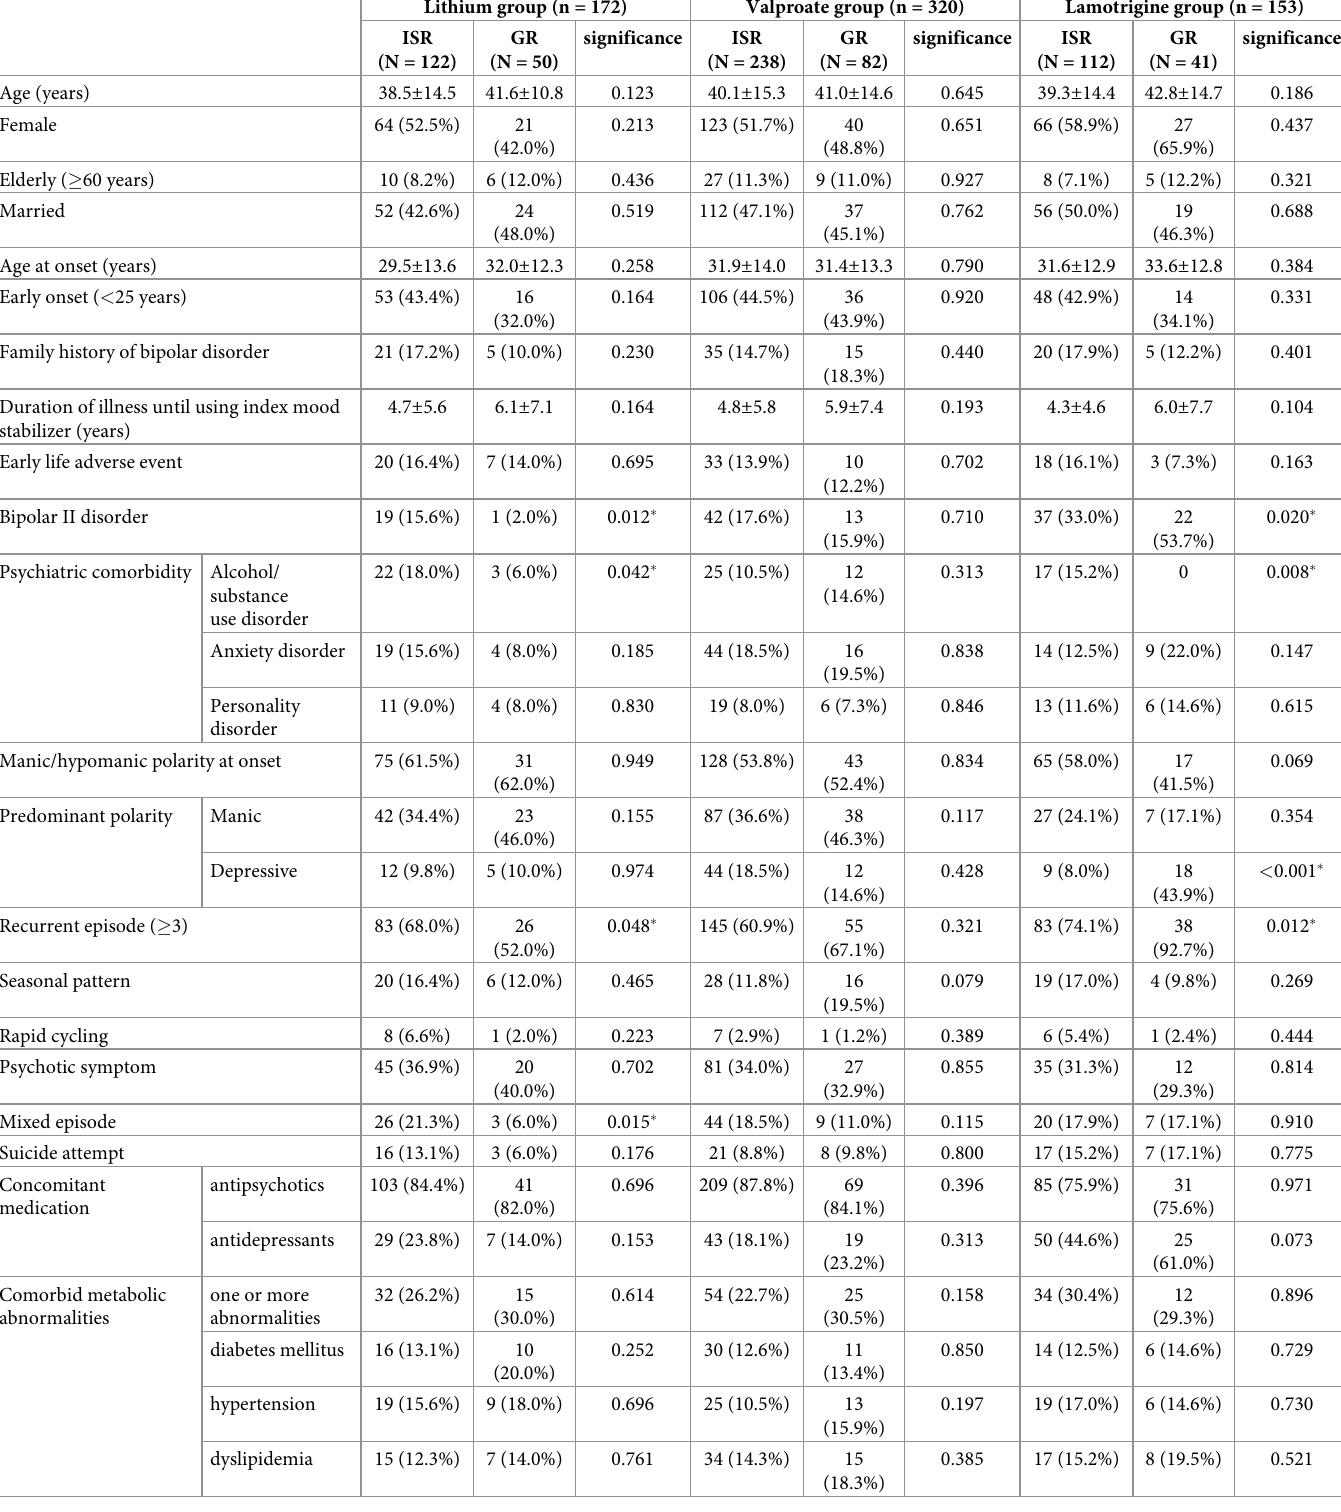
Table 3. Comparisons of sociodemographic and clinical characteristics between ISR and